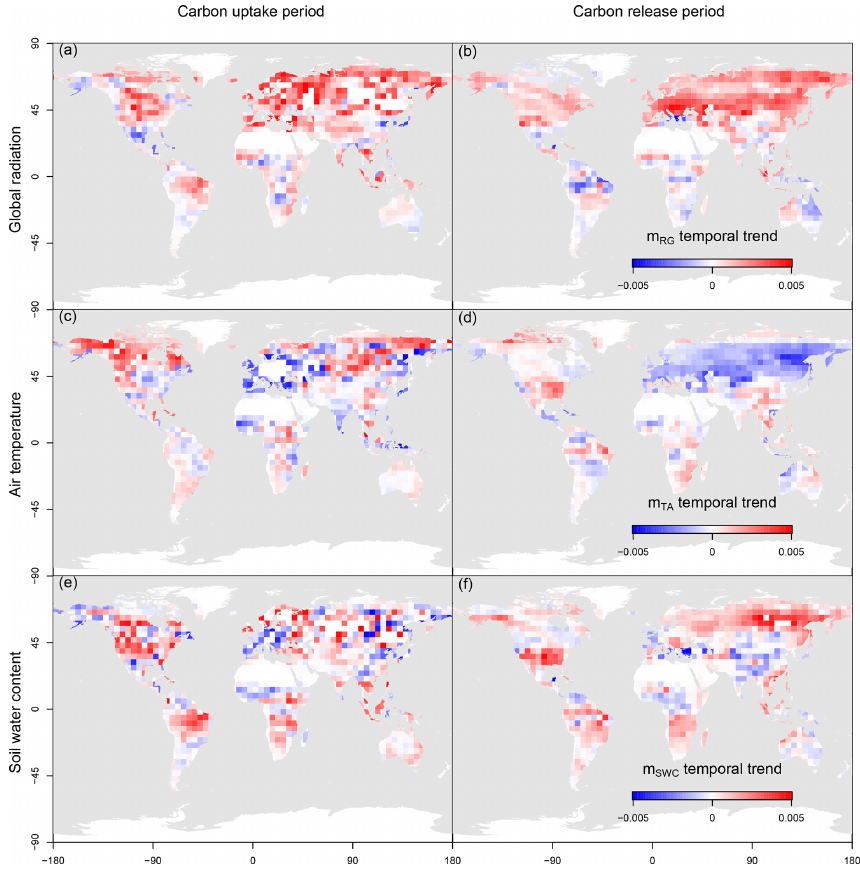
Figure 6. Maps of sensitivity temporal trends separately shown for the carbon uptake period (CUP, a, c, e ) and carbon release period (CRP, b, d, f ) at a weekly timescale. Maps are plotted for global radiation (a, b) , air temperature (c, d) and soil water content (e, f) .